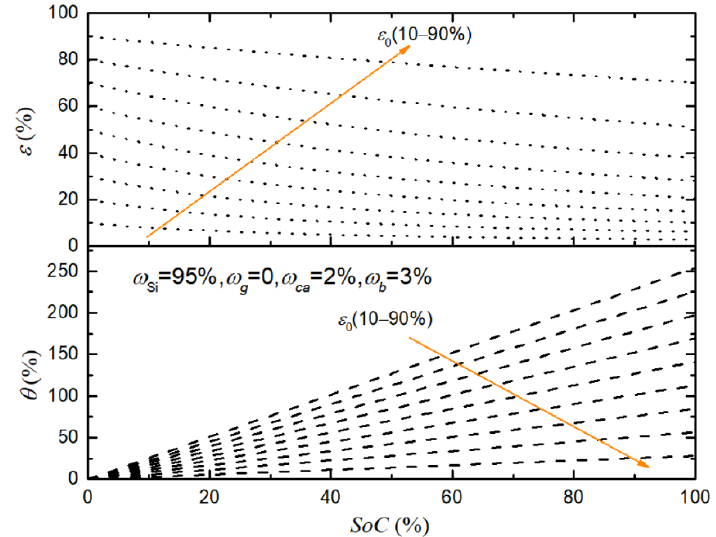
Figure 3. The evolution of porosity and volume strain with SoC for different initial porosities.